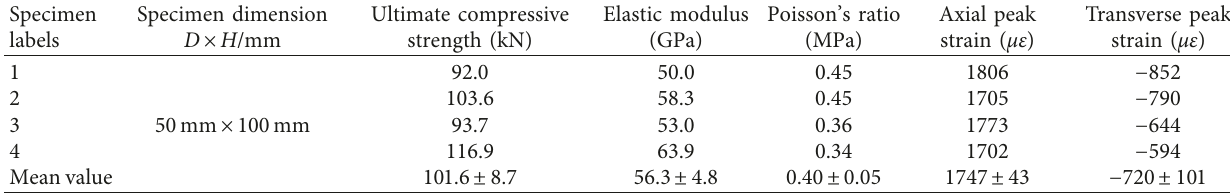
Table 3: Uniaxial compressive test results.